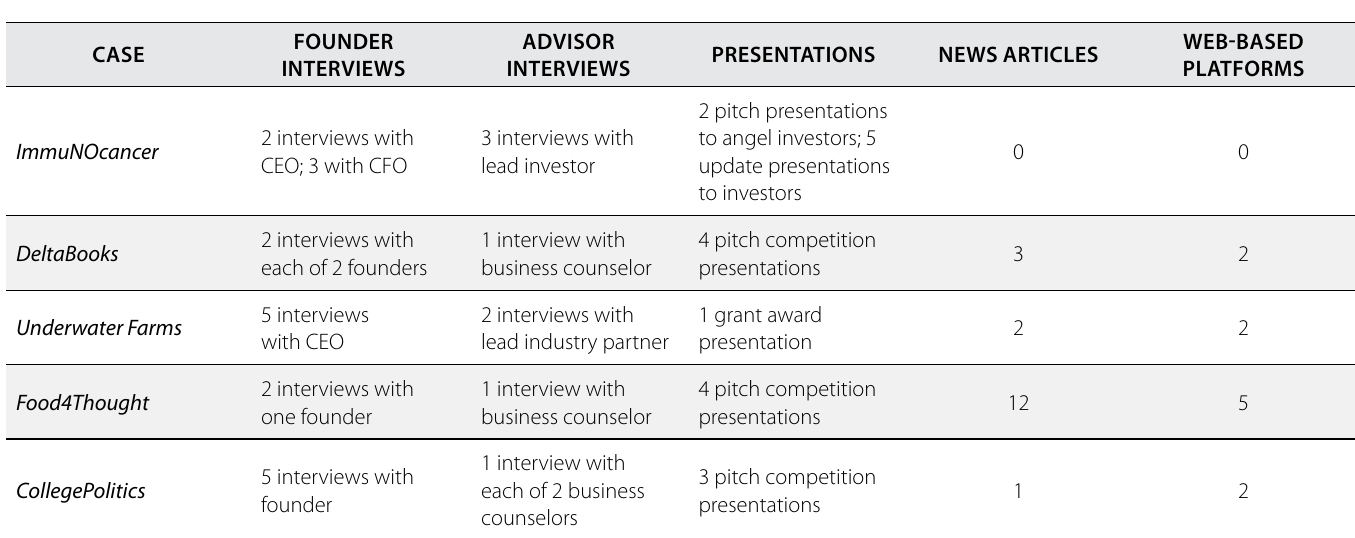
Table 3. Data Source Descriptions and